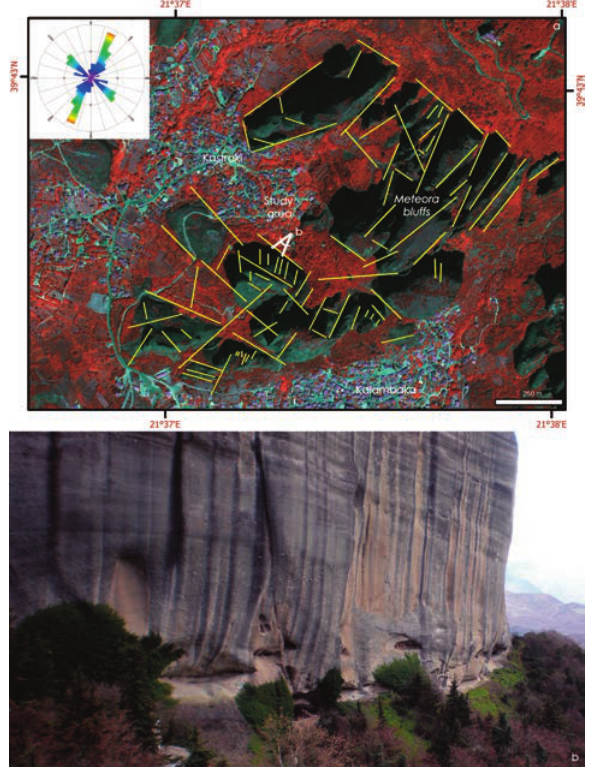
Figure 3. (a) Photogrammetric interpretation of an IKONOS-2 satellite image (4,2,3 - R,G,B) led to a photo-lineament map of the surrounding bluffs hosting the studied spring (Amvrakia). The inset rose-diagram is a result of the statistical interpretation of the lin- eaments’ strike frequency. (b) Most of the lineaments are surface expressions of faults such as the one shown in this figure, displacing the strata of the Meteora conglomerates for tenths of